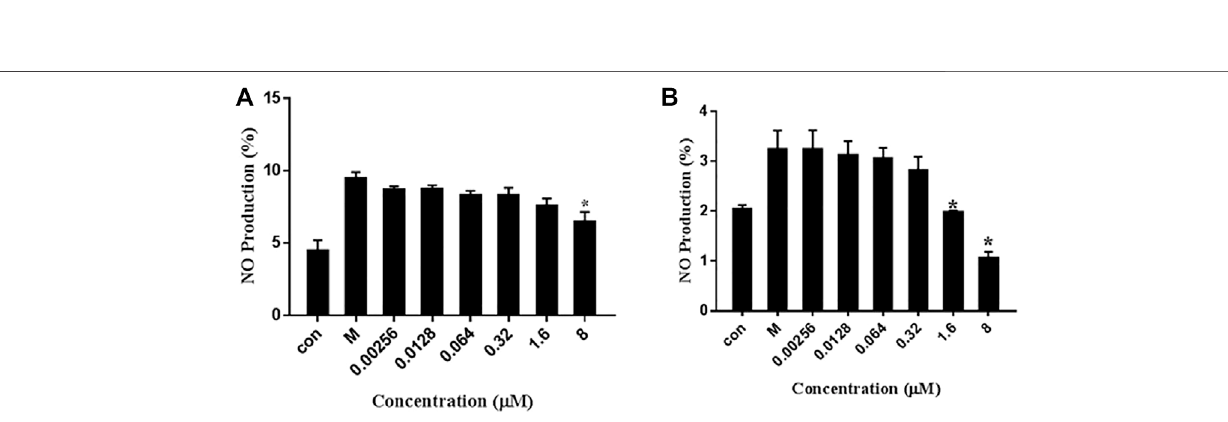
FIGURE 7 | Effects of 7979989 and Z112553128 on the Production of NO in LPS-Induced RAW264.7 Cells. Inhibition of the (A) 7979989 (B) Z112553128 on LPS-induced nitric oxide (NO) in RAW 264.7 macrophages. Each bar represents the mean ± standard deviation (SD) calculated from three independent experiments. * p < 0.05 compared with M group (only LPS-treated group).